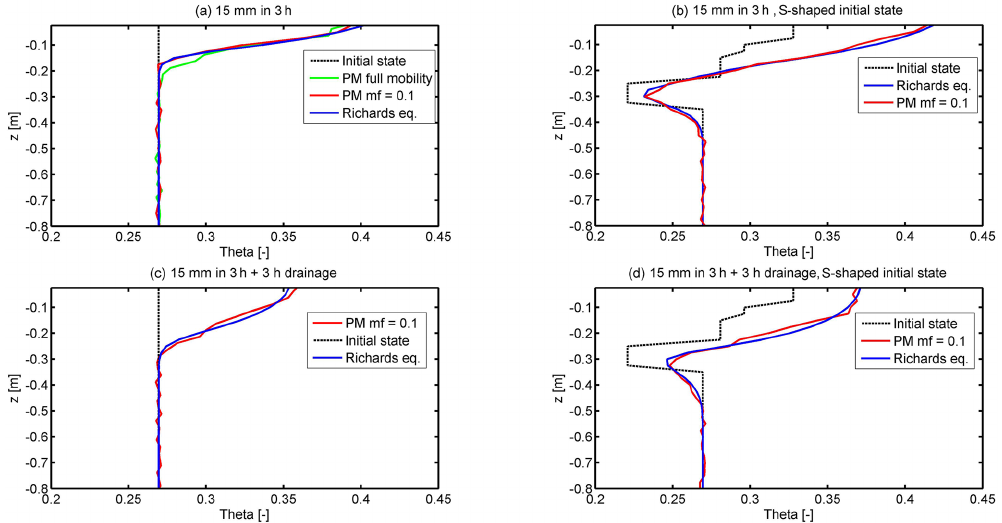
Figure 7. Final soil moisture profiles simulated for Calcaric Regosol on loess. Panels (a) and (b) compare the particle model in the full mobility model (solid green) and in a mobile fraction of 10% (solid red) to the Richards solver for a 15mm rainfall input in 3h and different initial patterns. Panels (c) and (d) compare the Richards solver and the particle model assuming a mobile fraction of 0.1 after 15mm infiltration in 3h and a subsequent drainage phase of 3h. The dashed grey line marks the initial soil moisture